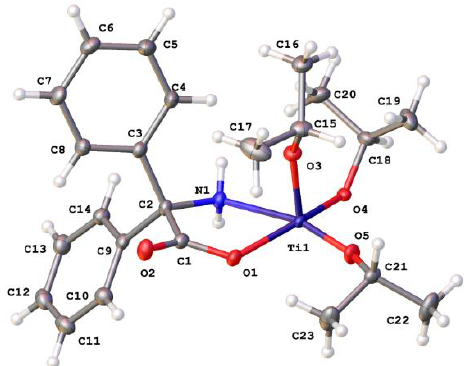
8 of 23 Figure 7. Asymmetric unit of 7 with atoms drawn as 50% probability ellipsoids. For clarity, minor disorder is not shown. Selected bond lengths (Å ) and bond angles ( o ): Ti(1)-Ti(1i) 3.2815(5), Ti(1)- O(1) 1.9868(13), Ti(1)-O(3) 1.8486(17), Ti(1)-O(4) 1.7717(12), Ti(1)-O(5) 2.048 (3), Ti(1)-N(1) 2.2829(14); O(5)-Ti(1)-O(1) 152.78(8), O(5)-Ti(1)-O(4) 96.15(9), O(5)-Ti(1)-N(1) 84.55(8), O(5)-Ti(1)-O(3) 104.04(9), O(4)-Ti(1)-O(1) 100.20(5), O(4)-Ti(1)-O(3) 100.42(7), O(4)-Ti(1)-N(1) 88.62(6), O(3)-Ti(1)-O(1) 94.27(6), O(3)-Ti(1)-N(1) 166.64(7), O(1)-Ti(1)-N(1) 74.31(5), Ti(1)-O(5A)-Ti(1i) 114.10 (18). The action of the inversion center generates a dimer from two Ti1 centres and a dimer from two Ti2 centers. There ar e intramolecular N‒H···O (alkoxide) hydrogen bonds that help to stabiliz e the dimers and N‒H···O(carbonyl) hydrogen bonds between adjacent complexes that form 1-D chains that run parallel to the crystallographic [1,1,1] direction. Views of the coordination about Ti1 and Ti2 are shown in the Supporting Information (Figure S8). The similar use of [Ti(O i Pr) 4 ] also resulted in the formation of a dinuclear complex, namely, [Ti 2 (L 2 ) 2 (O i Pr) 6 ] ( 8 ). Although the crystal structure is somewhat different (Figure 8; for an alternative view, see the Supporting Information, Figure S9), the basic cluster present in 8 is essentially the same as in 7 ; two Ti ions are bridged by a pair of alkoxides,